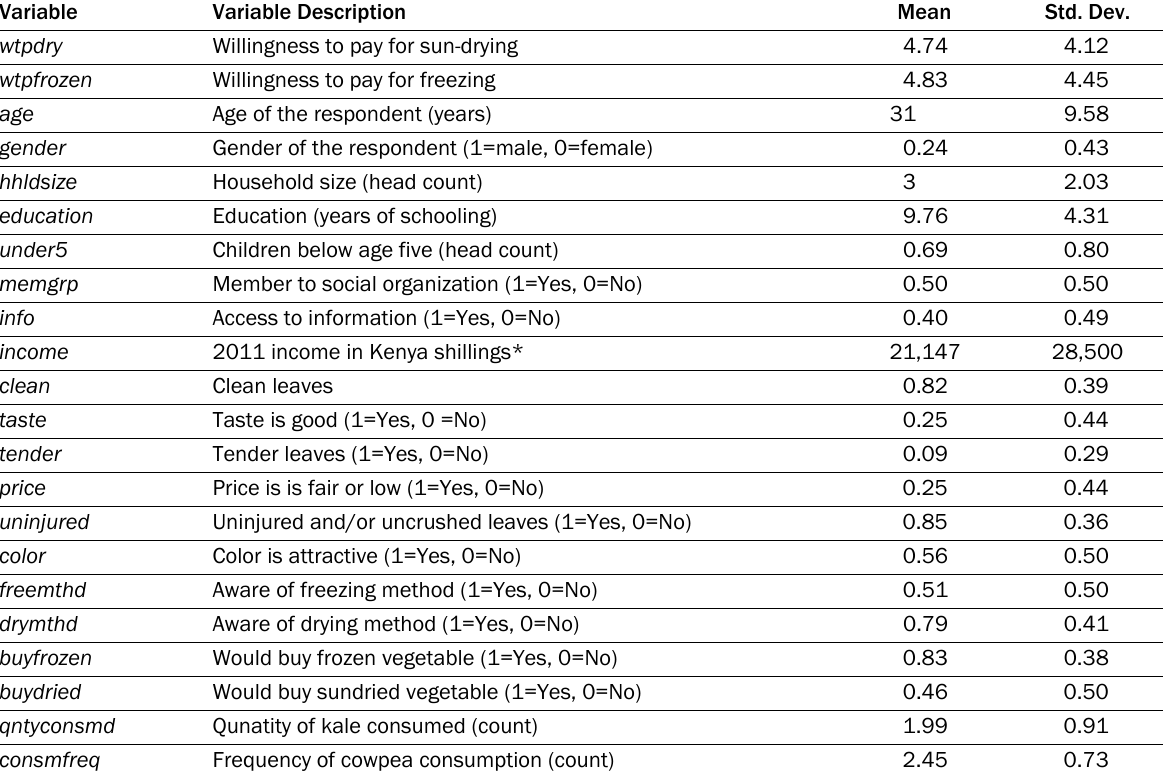
Table 2. Summary Statistics of the Variables Used in the Study Consumers’ Willingness to Pay for Value Addition in Cowpea ( N =147)